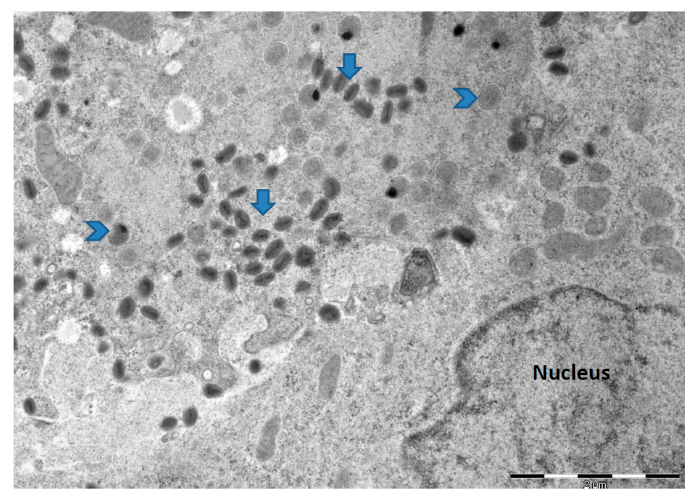
Figure 2. Electron micrograph of cell section of Caco-2 (ATCC HTB-37) cells infected with MVA obtained from passage 32 (p32). The infected cells were fixed 24 h post infection and processed for electron microcopy. Arrows indicate mature virions while arrow heads point to immature viruses. Similar electron micrographs were obtained for viruses harvested from p28 to p40. No mature virions were observed from cells infected with non-passaged MVA. Bar: 2µm.